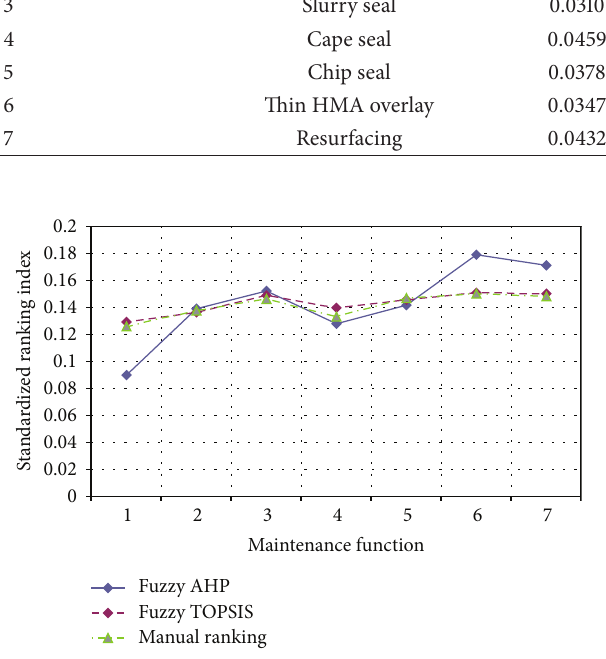
Figure 10: Comparison of maintenance prioritization results from fuzzy AHP and fuzzy